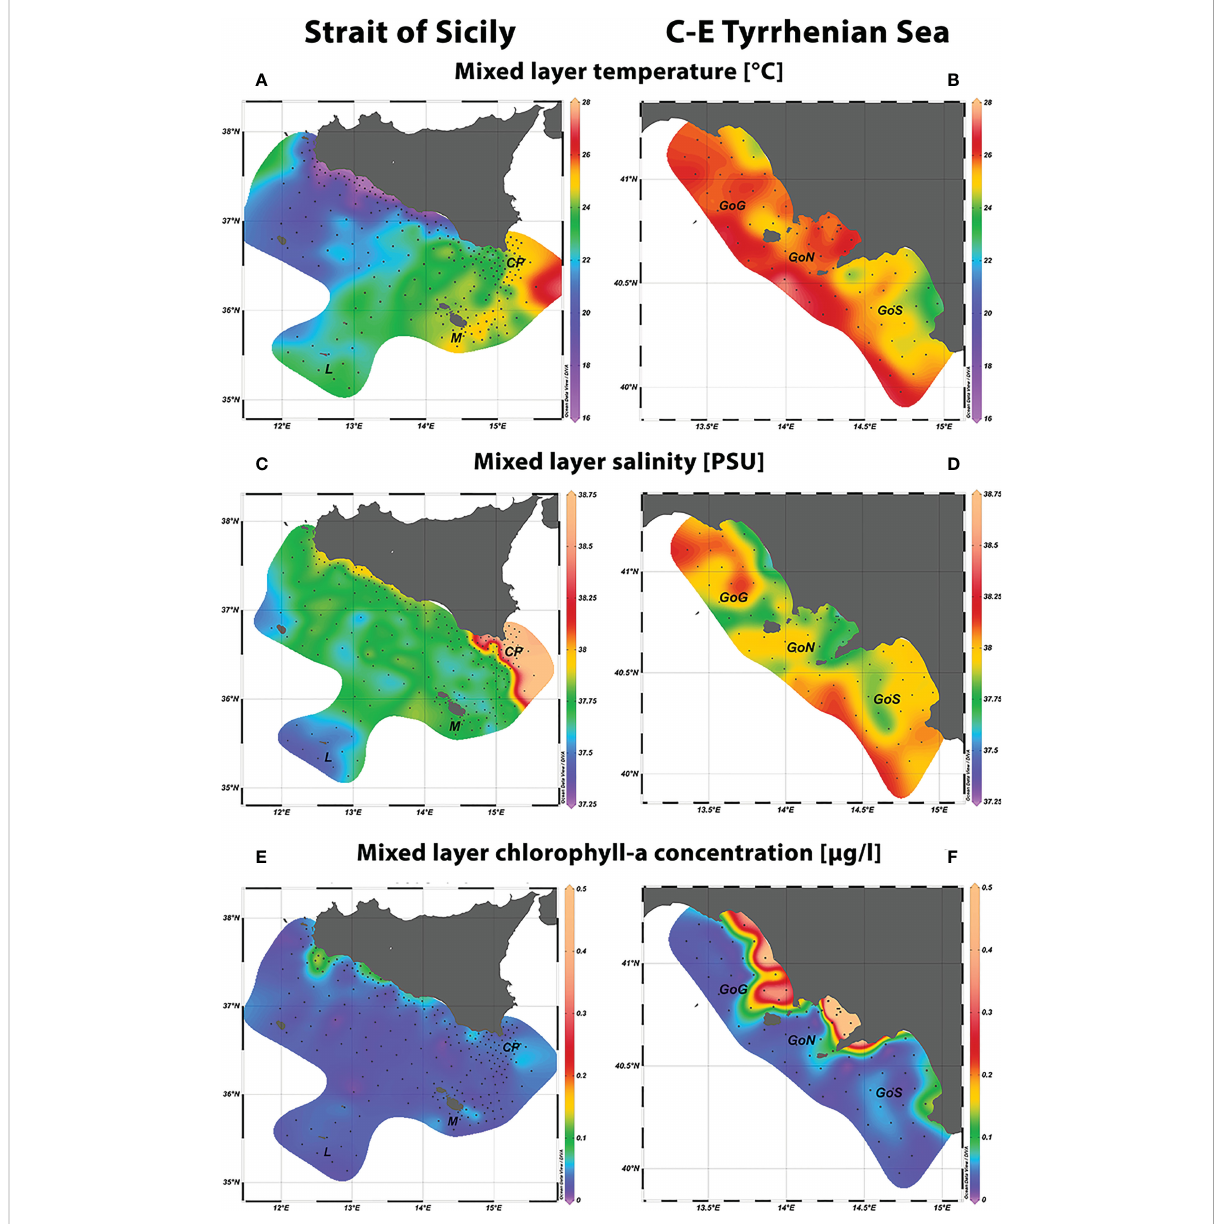
FIGURE 3 Spatial distribution of mixed layer temperature (A, B) , mixed layer salinity (C, D) , mixed layer chlorophyll-a concentration (E, F) recorded in situ in the two considered study